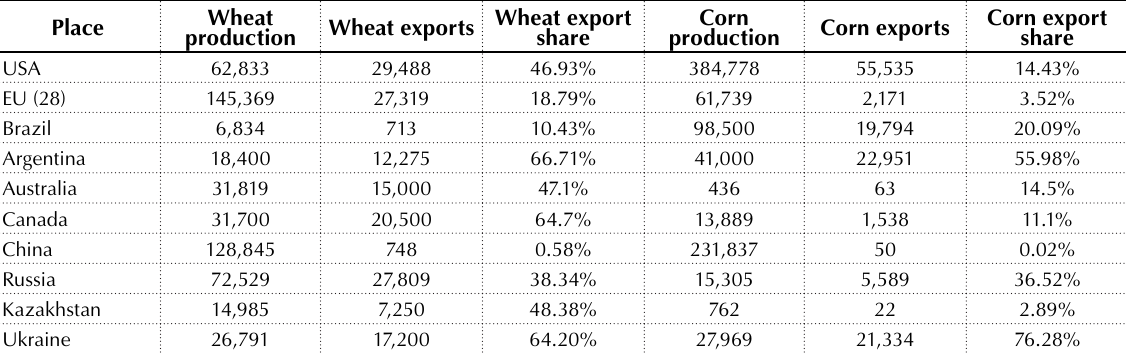
Table 4. Comparison of corn and wheat production and export, major producers, 1,000 metric tons, 2016–2017 market